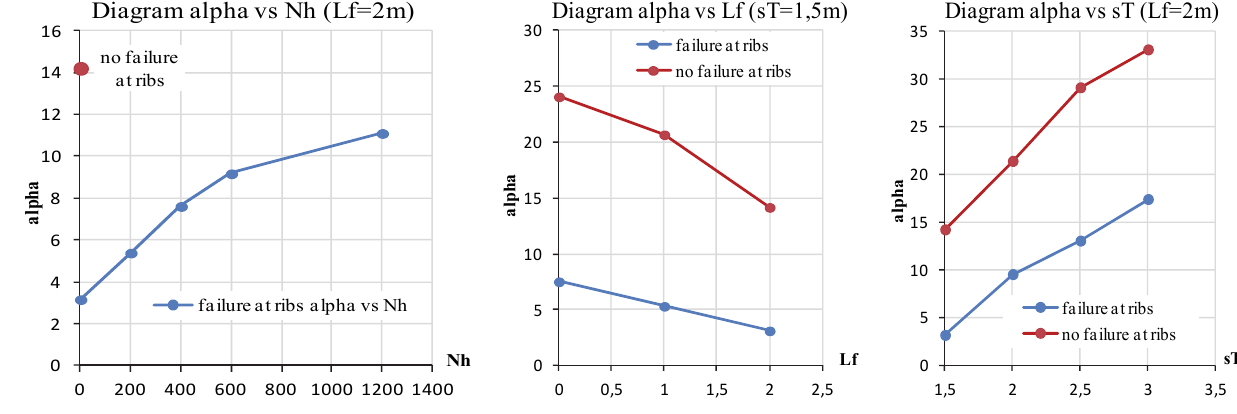
Figure 12: Variability of α  multiplier as a function of Nh, Lf and